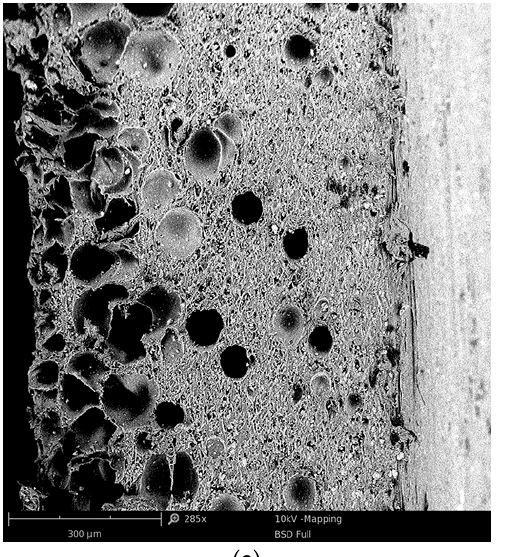
Figure 6. Fragment of the cross section of of the double coatings: ( a ) PVC + 0.2% BA; ( b ) PVC + 0.6% BA.